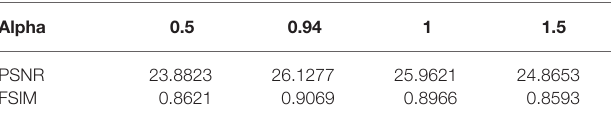
TABLE 3 | Experimental results with different values of the step thresholds.